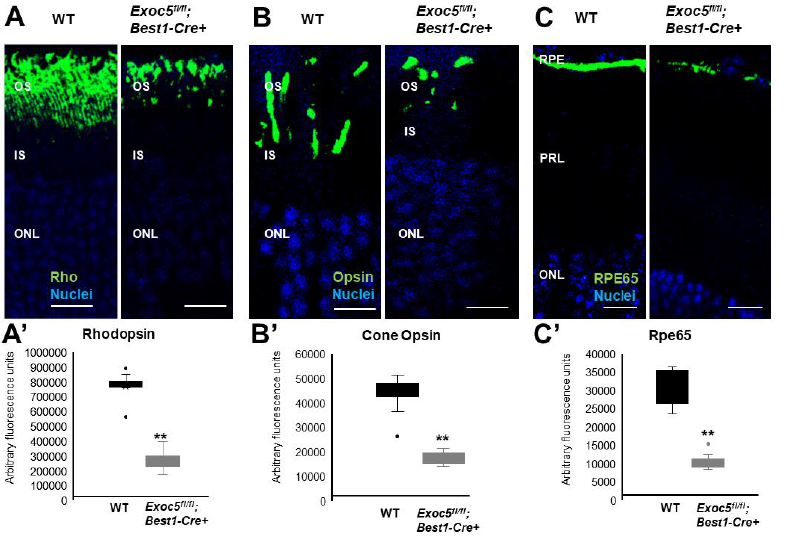
Figure 7. Immunohistochemical analysis of rod and cone photoreceptors in wild-type and conditional Exoc5 knockout mice at 27 weeks of age. Levels and localization of rhodopsin (green, Rho, ( A )), Red/Green cone opsins (green, R/G Opsin, ( B )), and RPE65 (green, RPE65, ( C )), were assessed using immunohistochemistry in retinal sections from mice collected at 27 weeks of age to identify alterations in rod and cone outer segments and RPE. Rod and cone outer segments are dysmorphic, and RPE staining for RPE65 was severely disrupted. Image J was used to quantify rhodopsin ( A’ ) and cone opsin ( B’ ) fluorescence in photoreceptors, and RPE65 ( C’ ) in RPE of WT and Exoc5fl/fl;Best1-Cre + mice. Scale bars = 50 μ m ( A – C ). OS, outer segments; IS, inner segments; ONL, outer nuclear layer, INL, inner nuclear layer; RPE, retinal pigmented epithelium. ** p < 0.05 (WT vs. Exoc5fl/fl;Best1-Cre + mutants). 2.5. Conditional Sec10 fl/fl, Best1-Cre + KO Mice Show Significantly Reduced Rod Visual Function and RPE Integrity as Assessed by Electroretinography (ERG) To correlate retinal structure with function, full-field ERG responses were analyzed, capturing ERG a - and b -waves under dark-adapted scotopic conditions to determine rod photoreceptor function, as well as b -waves under photopic conditions after light adapta- tion to determine cone function. In addition, c -waves were determined after a prolonged light flash to assess RPE integrity. Visual function was assessed in Exoc5fl/fl mice in the presence and absence of Best1-Cre at 6, 20, and 27 weeks of age. For ERGs with multiple light intensities, a repeated measure ANOVA followed by a post hoc ANOVA with Bon- ferroni correction was performed, individual amplitudes were compared by t-test. Within the wild-type/control group, an amplitude by genotype interaction was iden- tified for b - but not a -wave amplitudes ( a -waves, p = 0.15; b -waves, p < 0.02), which was driven by larger b -wave amplitudes at 20 weeks of age. In the Exoc5fl/fl;Best1-Cre+ mice an amplitude by genotype interaction was also identified for b - but not a -wave amplitudes ( a -waves, p = 0.33; b -waves, p < 0.03), which was driven by smaller b -wave amplitudes at 27 weeks of age ( p = 0.003). Cone amplitudes and c -wave amplitudes were unaffected by age in control mice, whereas in Exoc5fl/fl;Best1-Cre + mice, cone amplitudes remained sta- ble, but c -wave amplitudes dropped with age ( p = 0.025; 6 versus 27-weeks: p = 0.002) (Figures 8 and S4). When the amplitudes were analyzed within the age groups, but differentiated by genotype, the following conclusions could be drawn. At 6 weeks of age, there was no difference in visual function and RPE integrity between the control and Exoc5fl/fl;Best1-